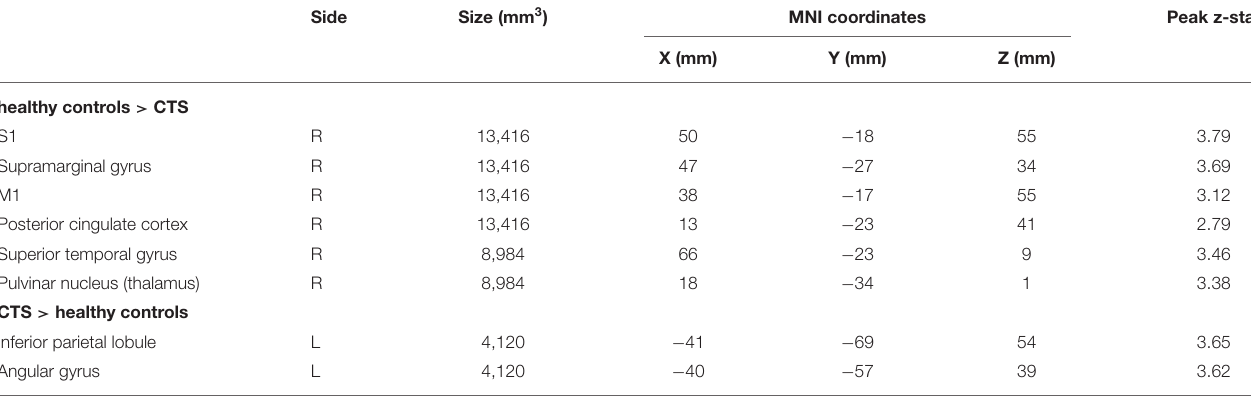
TABLE 1 | Resting-state D2 functional connectivity for CTS ( N = 64) vs. healthy controls ( N = 29). Side Size (mm 3 ) MNI coordinates Peak z-stat X (mm) Y (mm) Z